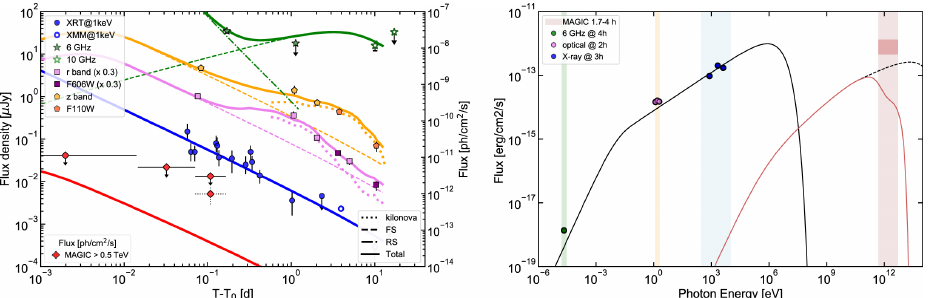
Figure 5. Multiwavelength light curve (left) and SED (right) of GRB 160821B compared with afterglow modeling (Figure 4 adopted from [309]). ©AAS. Reproduced with